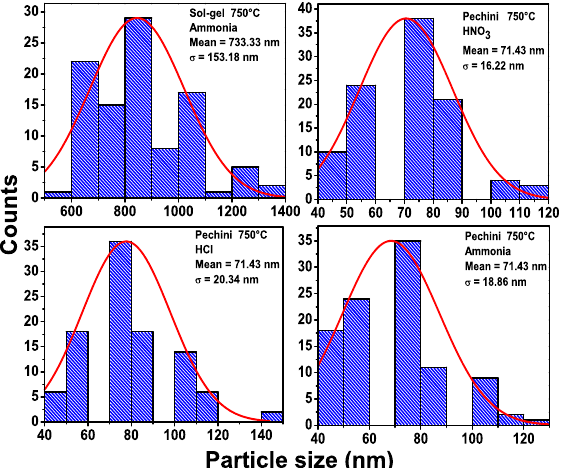
Figure 5. The plot shows the amount of particles vs. size of the particle. In a count of 100 particles, the sample was calcined at 750 ◦ C for 2 h: ( a ) Sol-gel (NH 4 OH) the average size is 733.3 nm and ( b ) Pechini (HNO 3 ), ( c ) Pechini (HCl) and ( d ) Pechini (NH 4 OH) by the Pechini method the average size is 71.43 nm.